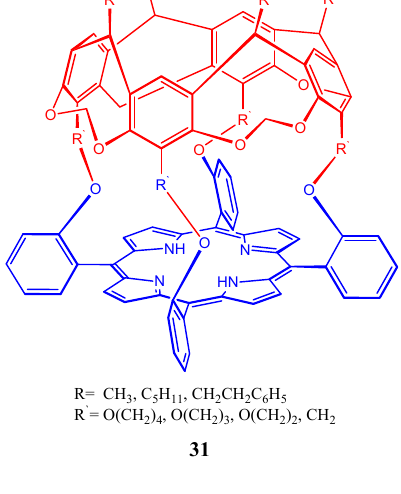
Figure 31. Representation of the resorcin[4]arene-capped porphyrin capsule ( 31